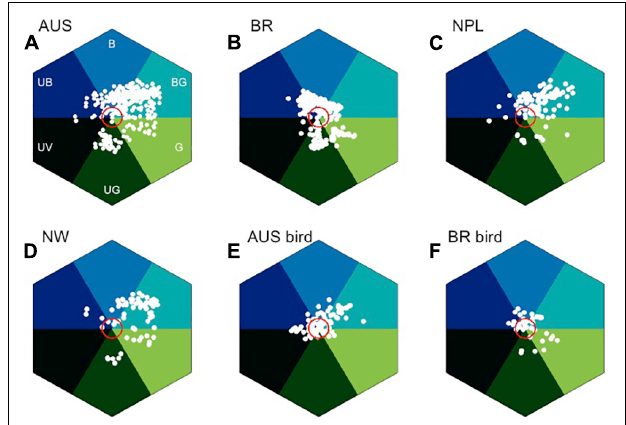
FIGURE 8 | In search of blue: bee color space for four different countries, and also considering separately bird pollinated where quality data are available. (A) Australian insect-pollinated flowers (AUS, n = 146), (B) Brazilian bee-pollinated flowers (BR, n = 245), (C) Nepal (NPL, n = 107), (D) Norway (NW, n = 77), (E) Australian bird-pollinated flowers ( n = 92), and (F) Brazilian hummingbird-pollinated flowers ( n = 39). Red circle is 0.11 hexagon unit which shows the achromatic region where bees are predicted to be poor at detecting colors against a foliage background, showing that bird-pollinated flowers are more frequently achromatic considering bee color perception. Hex sector values are available in Supplementary Appendix 3 .